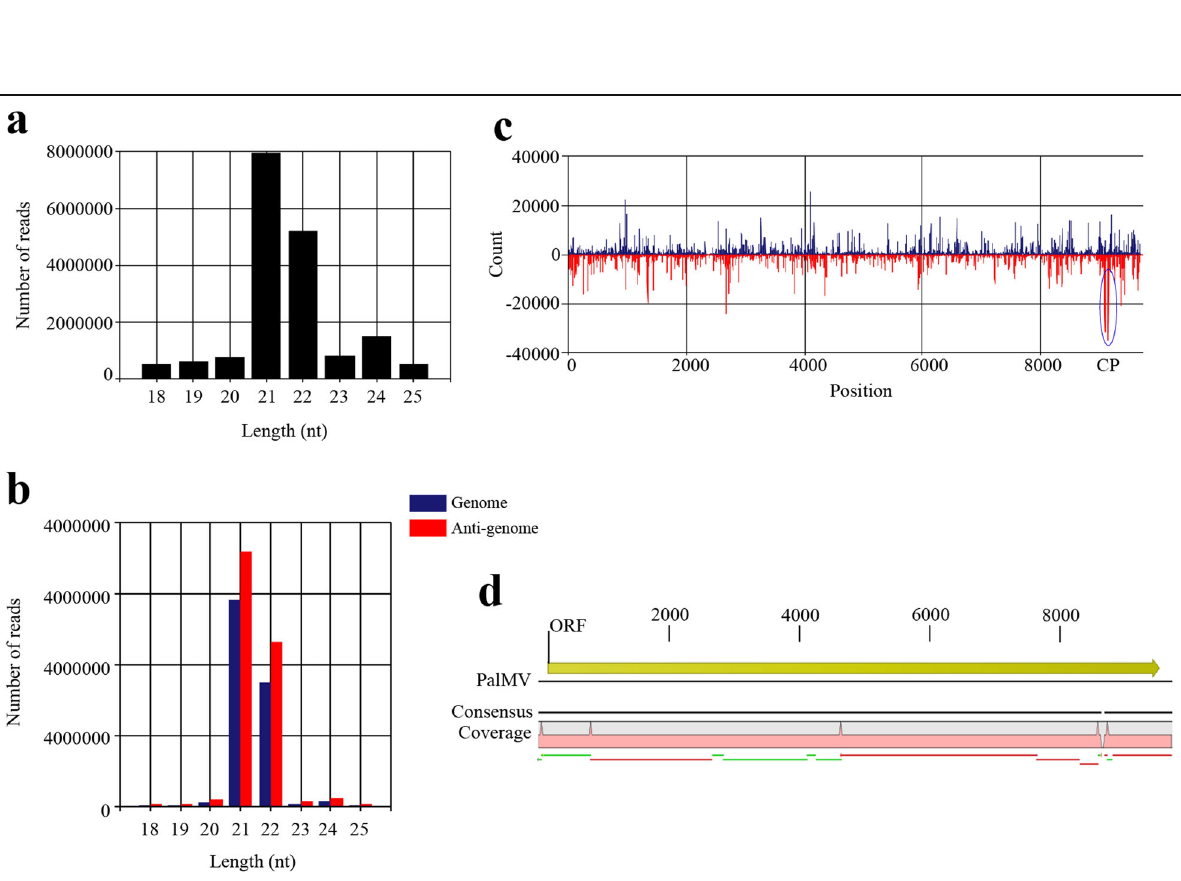
Fig. 2 Profile of vsiRNAs and contigs derived from library of PalMV-infected leaves. a Histogram representation of size distribution of total sRNAs in the library. b Histogram representation of total vsiRNA reads in each size class from genome and anti-genome. c Map of vsiRNAs reads at each nucleotide position of the PalMV genome. Bars above the axis represent sense reads starting at each respective position, and those below represent antisense reads ending at the respective position. d Map of continuous contigs covering most of the virus genomic sequence, except for a few